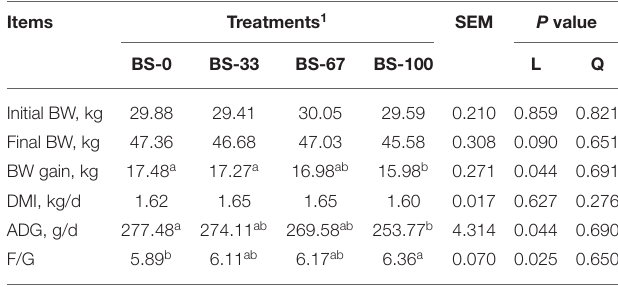
TABLE 3 | Effects of dietary barley starch proportion on performance of fattening Hu sheep ( n =